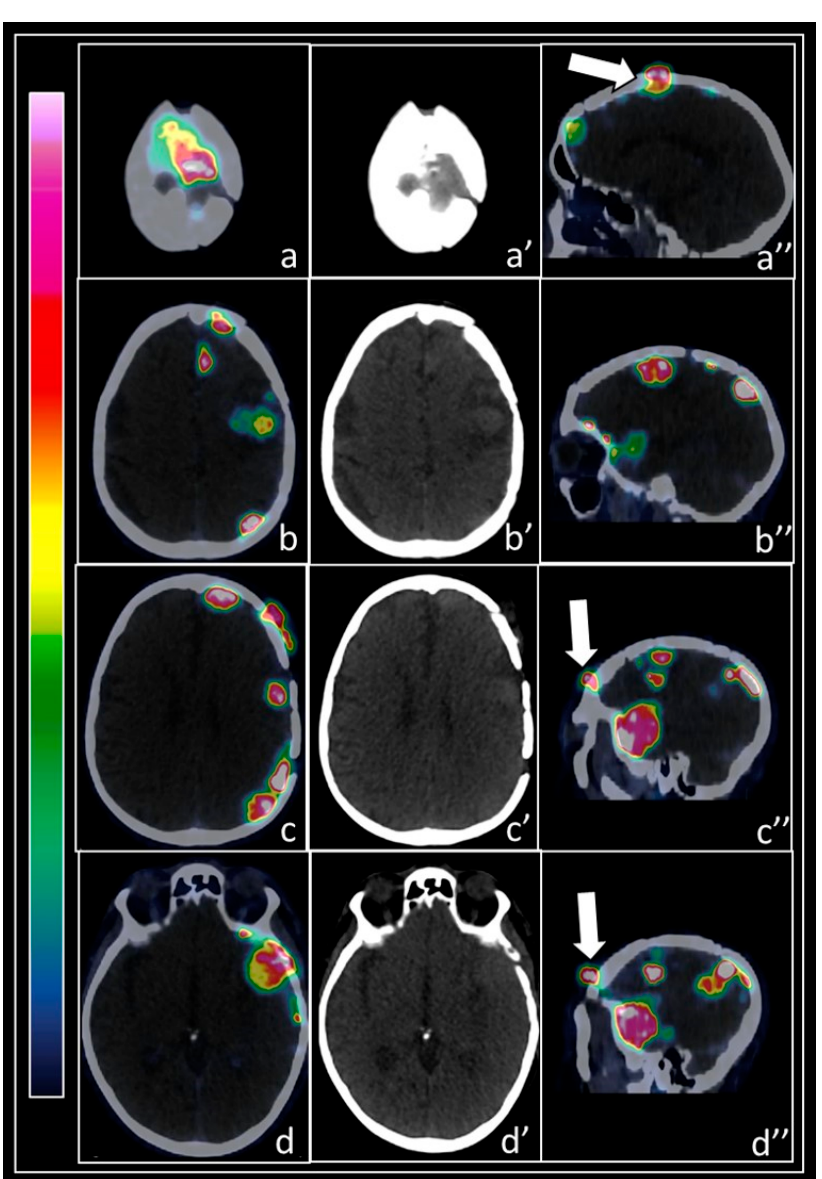
Figure 1. A 70-year-old patient with multiple meningiomatosis, already submitted to several consecutive interventions of surgical excision in the left-brain hemisphere and two treatments with cyberknife stereotactic radiosurgery for recurrences, was examined by brain PET/CT with 68 Ga-DOTATOC for an evaluation of tumor extent as suggested by Laudicella et al. [34]. PET/CT displayed multiple foci of pathologic tracer uptake in the left-brain hemisphere, particularly in the cranial vertex, as shown in the axial PET/CT ( a ) and CT ( a’ ) views, corresponding to a tracer-avid lesion protruding into the scalp, also evident in the correlative sagittal PET/CT view ( a’’ , arrow). The patient clinically presented skull deformation in the vertex of the skull. Other tracer-avid parafalcal and subcortical lesions were also detected, shown in the axial PET/CT ( b ) and CT ( b’ ) views and correlative sagittal PET/CT view ( b’’ ). Moreover, multiple cortical tracer-avid lesions were observed in the left-brain hemisphere, as evident in axial PET/CT ( c ) and CT ( c’ ) details. Some of these lesions were protruding into the subcutaneous tissues in the left frontal region, as depicted in the sagittal PET/CT view ( c’’ , arrow). Finally, intense 68 Ga-DOTATOC uptake was recorded in a slightly hyperdense area in the left temporal region, invading subcutaneous soft tissues in the ipsilateral scalp. This finding is summarized in the axial PET/CT ( d ) and CT ( d’ ) views and sagittal PET/CT view ( d’’ , arrow).